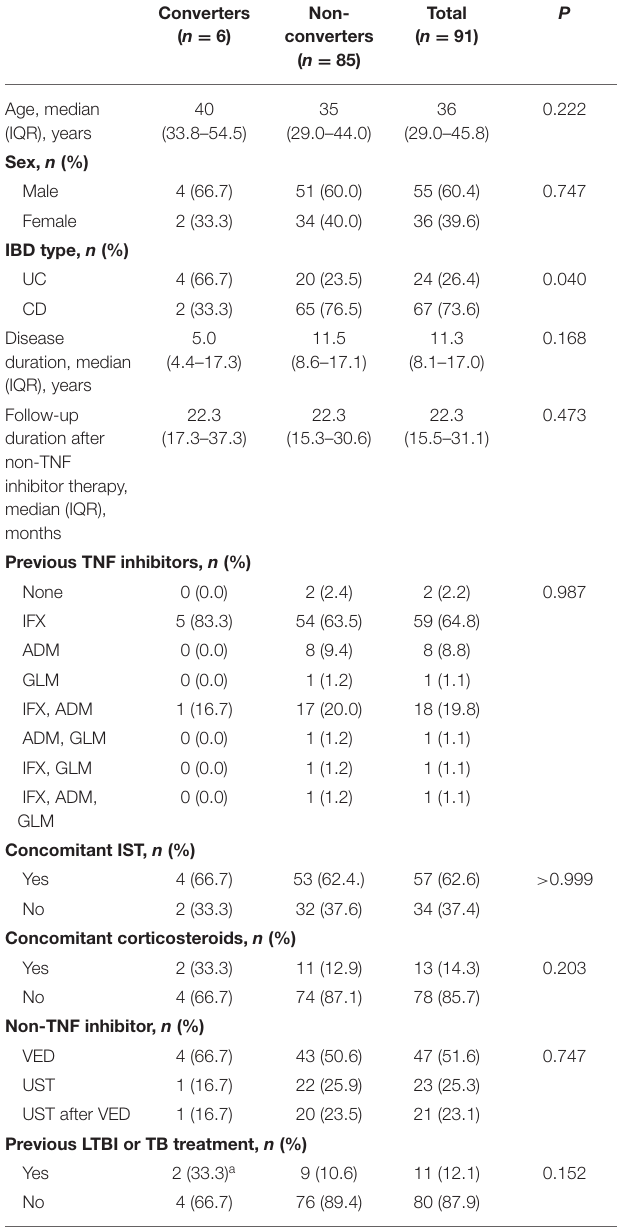
TABLE 1 | Demographic and clinical characteristics of patients.